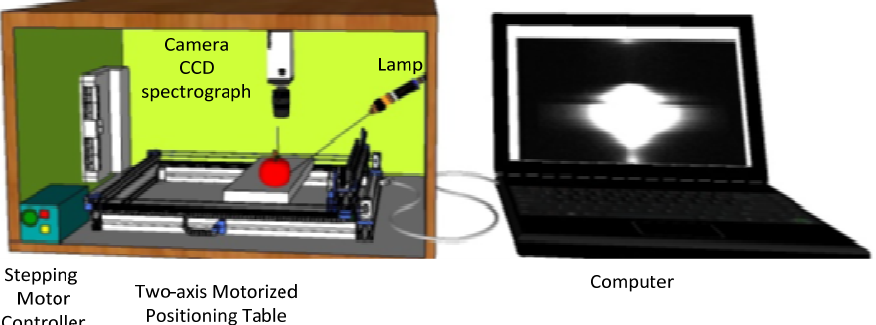
Figure 11. Multispectral system for lycopene measurement from Qin et al. [85]. Liu et al. [9] developed a system using multispectral images with chemo-metric methods to measure lycopene and the phenolic compounds in tomato. This system operated with 19 wavelengths from 405 to 970 nm. The total samples used for calibration and validation were 162 fruits in different stages of maturity. When calibrating, they used two- thirds of the total of fruits and the rest during validation. The proposed models to measure lycopene are partial least squares regression (PLS), the least squares support vector machine (LS-SVM), and the backpropagation neural network (BPNN). According to its re- sults, BPNN obtained the best results for its R 2C calibration of 0.957 and the R 2p prediction of 0.938.